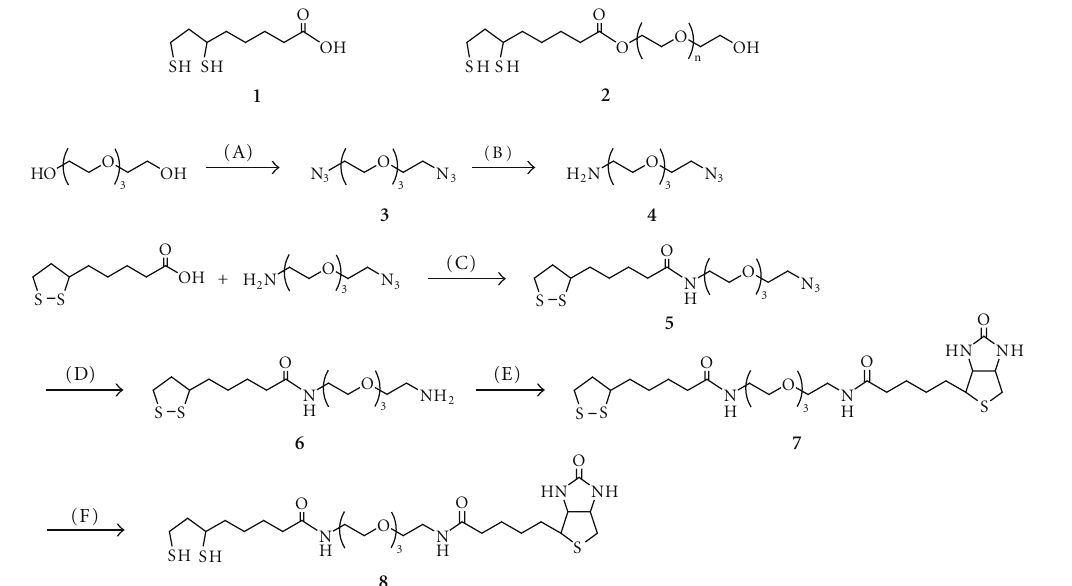
Figure 1: Chemical structures and synthetic routes of the surface ligands used in this study: (A) (i) MsCl, Et 3 N, THF, 0 ◦ C → 20 ◦ C, 20 hours; (ii) NaN 3 , NaHCO 3 , H 2 O, 70 ◦ C, 14 hours; (B) PPh 3 , 0.7 M H 3 PO 4 , Et 2 O, < 5 ◦ → room temperature, 16 hours; (C) DCC, DMAP, CH 2 Cl 2 , 0 ◦ C, 2 hour → room temperature, 20 hours; (D) PPh 3 , H 2 O, THF, reflux, 20 hour → room temperature, 20 hours; (E) Biotin N -hydroxysuccinimide ester, Et 3 N, DMF, room temperature, 16 hours; (F) NaBH 4 , EtOH, H 2 O, room temperature, 4